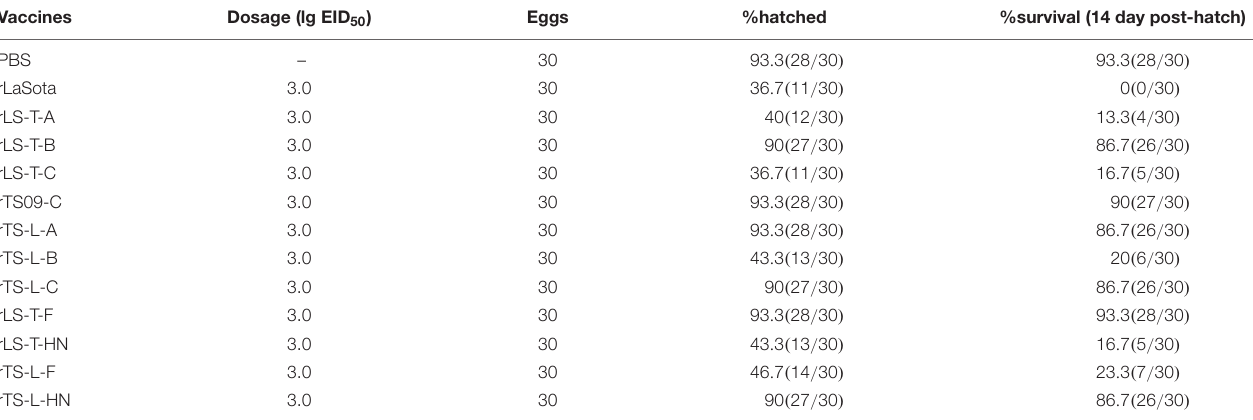
TABLE 1 | Hatchability and survival rates of SPF chickens vaccinated in ovo with different NDV chimeras. Vaccines